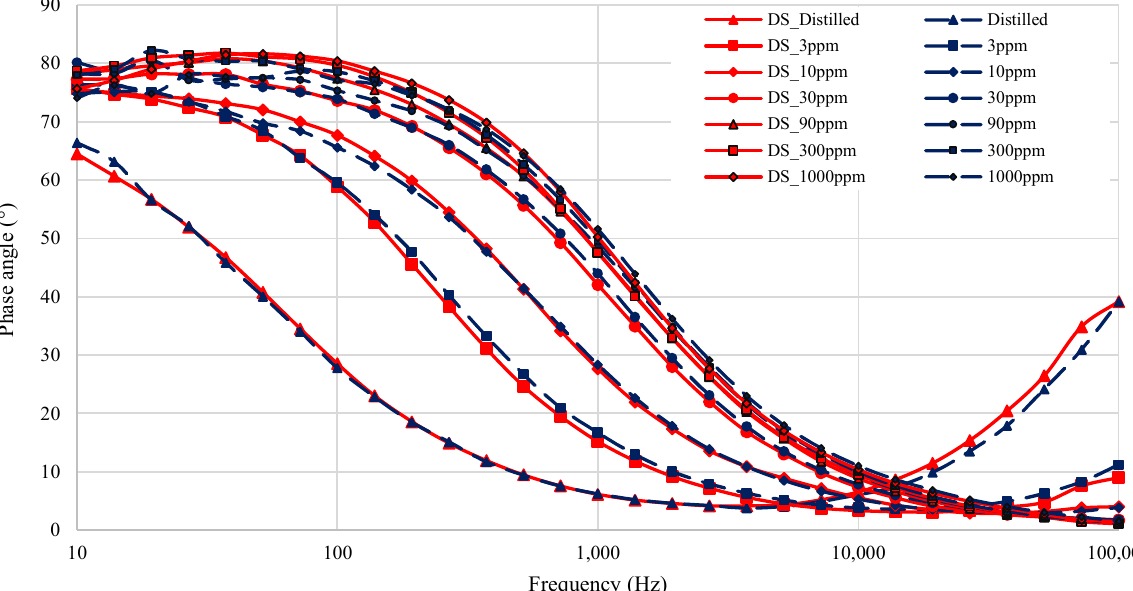
Figure 10. Figure showing phase angle of all seven solution measurements after calibration. All DropSens µStat-i 400s measurements are in red, with low-cost impedance measurements in